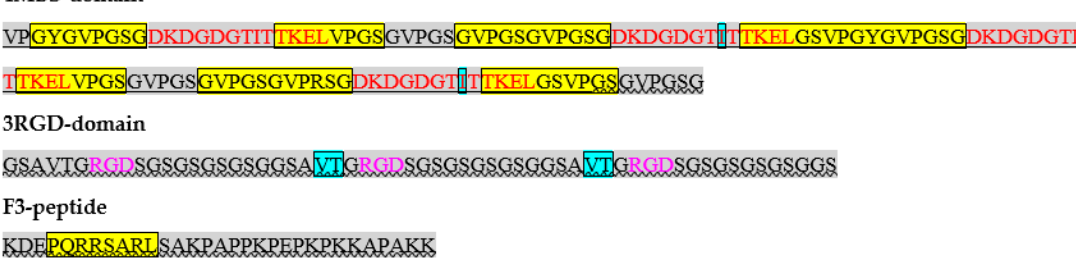
Figure 1. Putative secondary structure of the 4MBS-domain, 3RGD-domain, and F3-peptide predicted by trRosetta. MBSs are shown in the red font, α -helices are shown in boxes with yellow highlighting, β -strands appear in boxes with blue highlighting, and the residues in the coil conformation are highlighted with grey. The residues underlined with a straight line are putatively fixed in an ordered conformation, while the residues underlined with a wavy line have a disordered conformation.